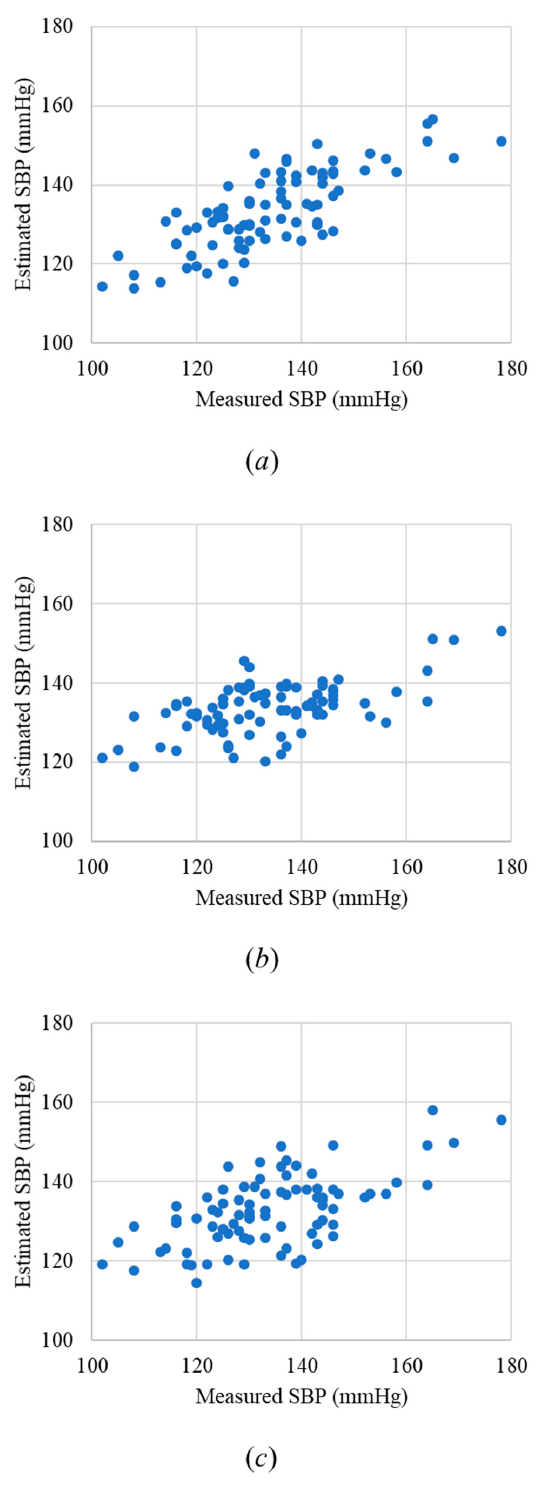
Figure 5. Scatterplots of the results: ( a ) our proposed method, ( b ) comparison method 1, and ( c ) comparison method 2.